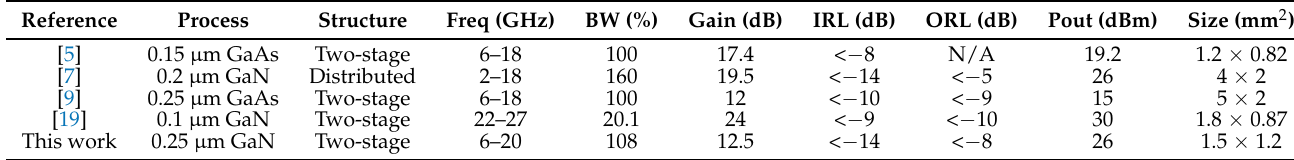
Figure 12. Comparison between simulated and measured quiescent current. Table 2. Comparison with previously published broadband